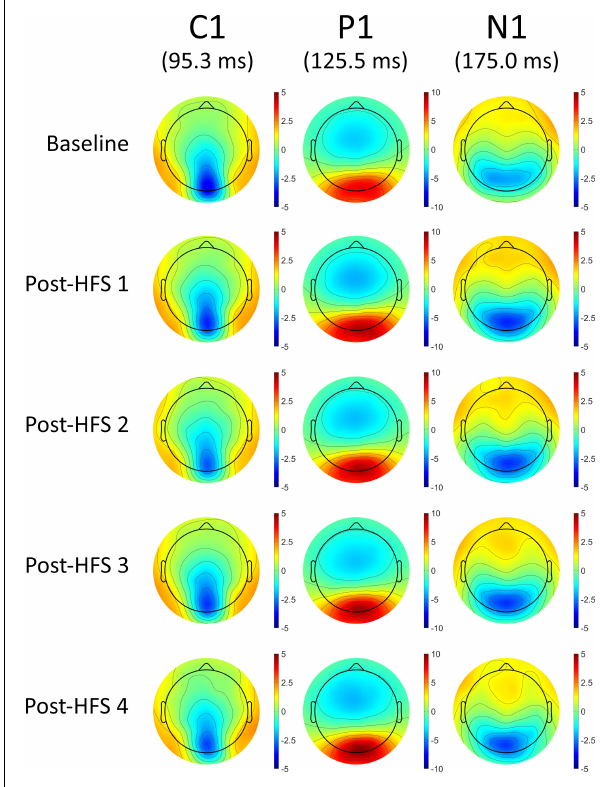
FIGURE 3 | Topographical voltage maps of the VEP components C1, P1, and N1.